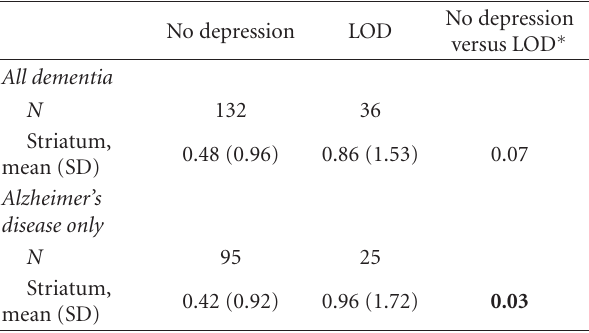
Table 6: number of striatal hypodensities in late-onset depression compared with no depression for all dementia and Alzheimer’s disease